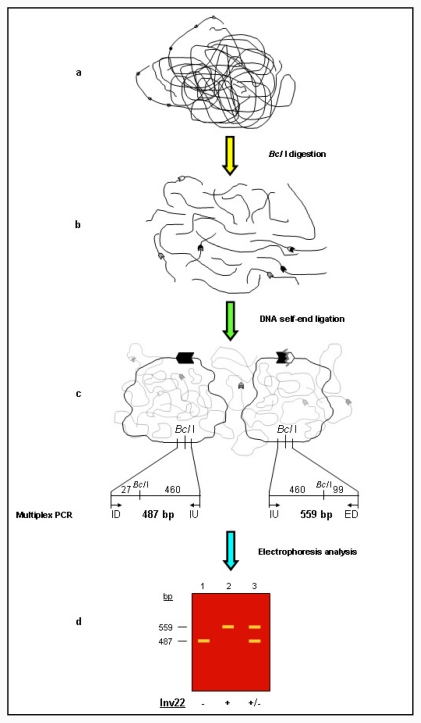
Schematic view of the inverse shifting-PCR approach. The simpler version of IS-PCR was described by Rossetti et al. (2005) [15] and involves three steps: (a) genomic DNA is subjected to restriction digestion yielding fragments (in this case Bcl I fragments), (b) restriction fragments self-end ligation (performed in large volumes), which forms (c) DNA circles that represent templates for a standard multiplex PCR analysis (on background some non relevant circles are shown); (d) PCR products from relevant circles are resolved by conventional electrophoresis. Lane 1 shows wild-type allele-specific products (-), lane 2, a male patient hemizygous for Inv22 (+), lane 3, heterozygous Inv22 carrier female (+/−). On the diagram int22h-1 is shown as a closed chevron; int22h-2 and int22h-3 as grey and open chevrons, respectively. Oligonucleotide primer ID indicates intragenic downstream, IU, intragenic upstream and ED, extragenic downstream.